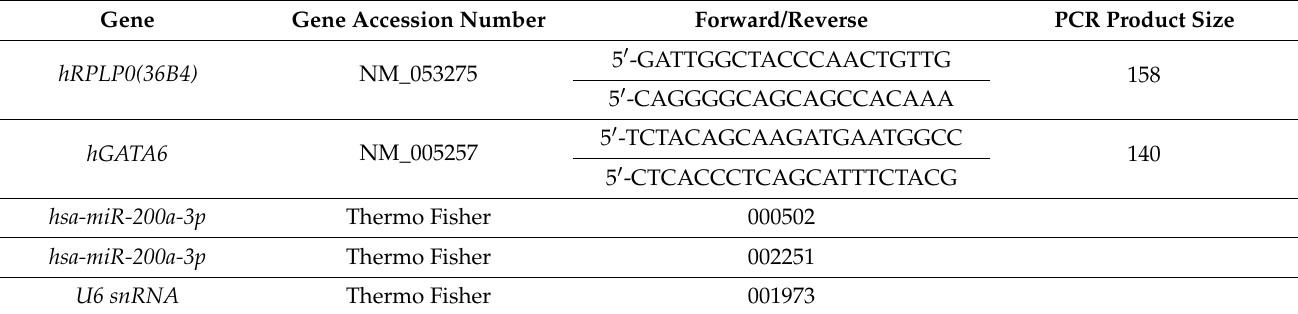
Table 2. Oligonucleotides used for